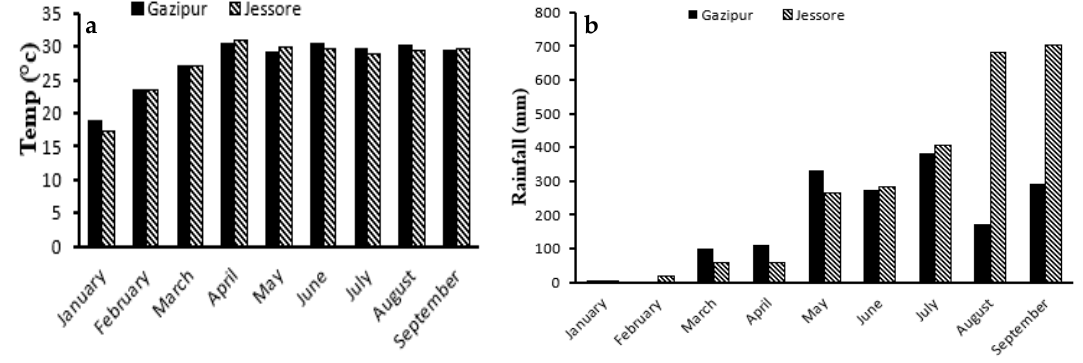
Figure 3. Monthly total Temperature ( a ) and Rainfall ( b ) of Gazipur and Jessore.